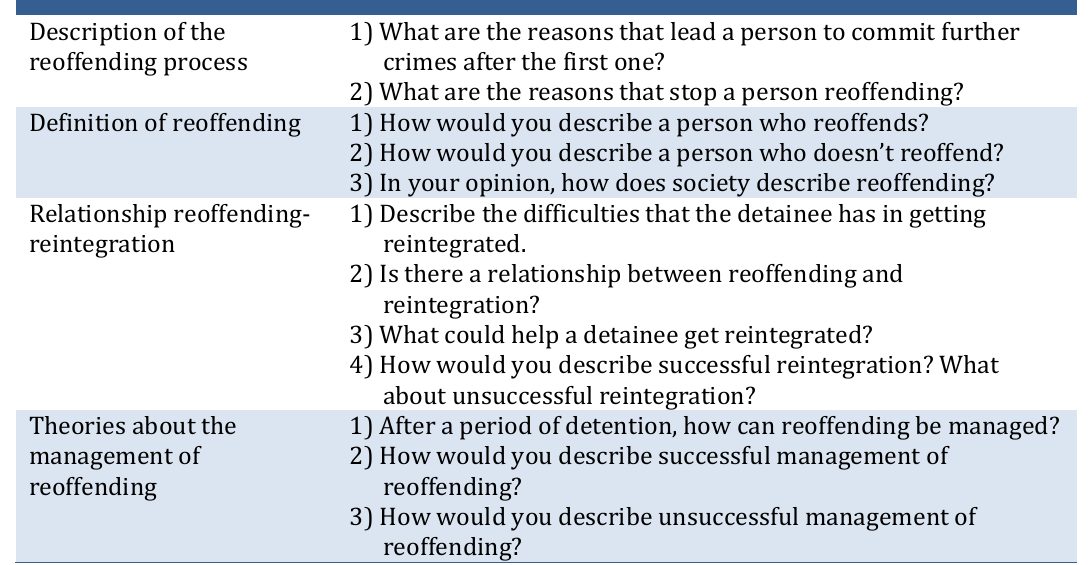
Table 2: Survey areas and